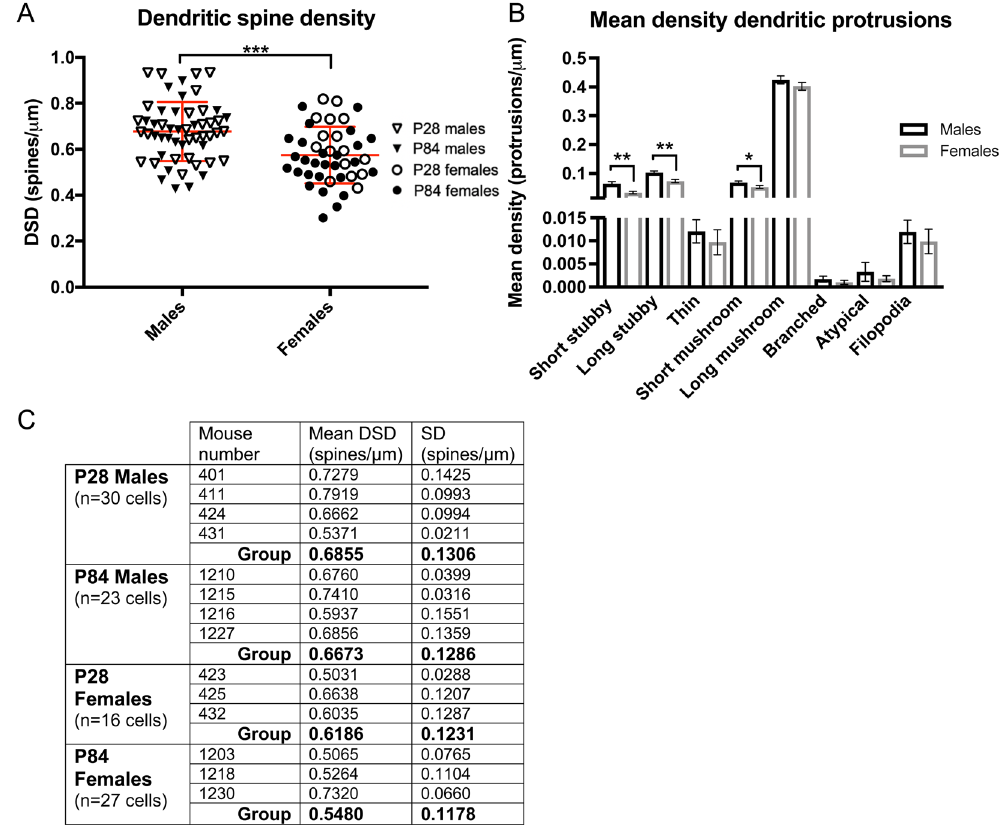
Figure 1. Sex differences in dendritic spine density (DSD) and mean density dendritic protrusions. ( A ) DSD is significantly reduced in female, compared to male mice (F = 14.838, DF = 3, p < 0.001). There were no significant sex by age, sex by region nor sex by layer interactions. Data points are DSD from individual neurons. Mean DSD and SD represented by red lines. ( B ) Short stubby (F = 12.408, DF = 1, p = 0.001), long stubby (F = 10.338, DF = 1, p = 0.002) and short mushroom (F = 5.834, DF = 1, p = 0.018) densities are significantly reduced in female mice with no significant age by sex interactions. Error bars = SEM. ( C ) Mean DSD for each animal. There is a trend level reduction in mean DSD in female, compared to male mice (F = 4.846, DF = 1, p = 0.055). Mean DSD is not significantly different from P28 to P84 (F = 0.005, DF = 1, p = 0.943). The age by sex interaction was not